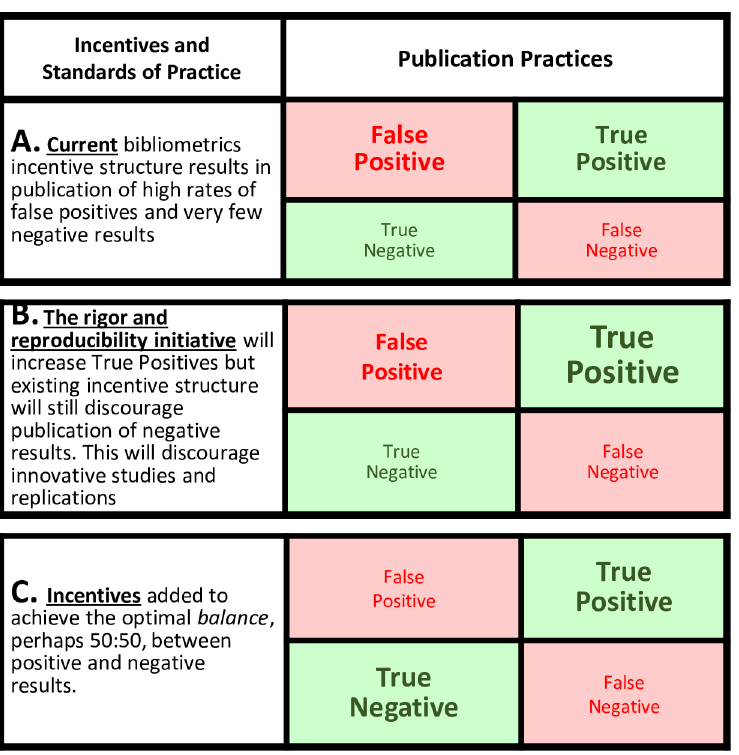
Fig 2. Standards of practice and publication patterns. Font size represents relative numbers of publications in each category.